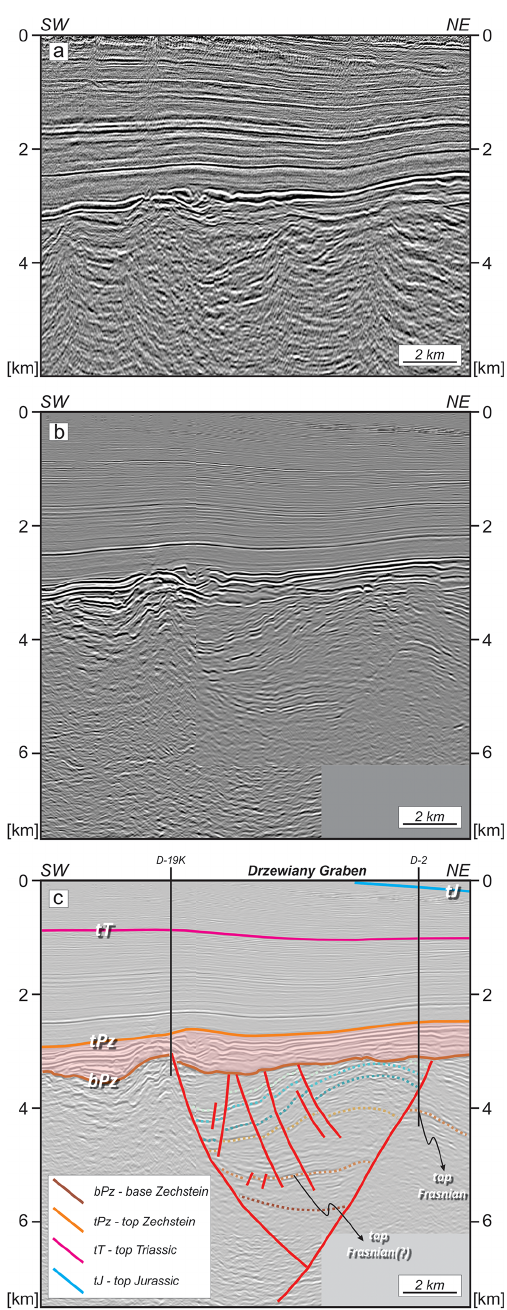
Figure 7. Comparison of recently reprocessed vintage 1977 2-D seismic data (a) and recently acquired 3-D seismic data (b) . Signif- icant improvement in sub-salt (i.e. sub-Zechstein) seismic imaging is clearly visible. (c) The inverted Drzewiany Graben. Dotted brown lines: upper Devonian (Frasnian–Famennian?) horizons; dotted blue horizons: lower Carboniferous (Tournaisian) horizons calibrated by the D-2 well. Devonian stratigraphy within the Drzewiany Graben is conjectural only and based on similarity to the seismic character- istics of the Upper Devonian strata drilled by the D-2 well within the footwall of the Drzewiany master